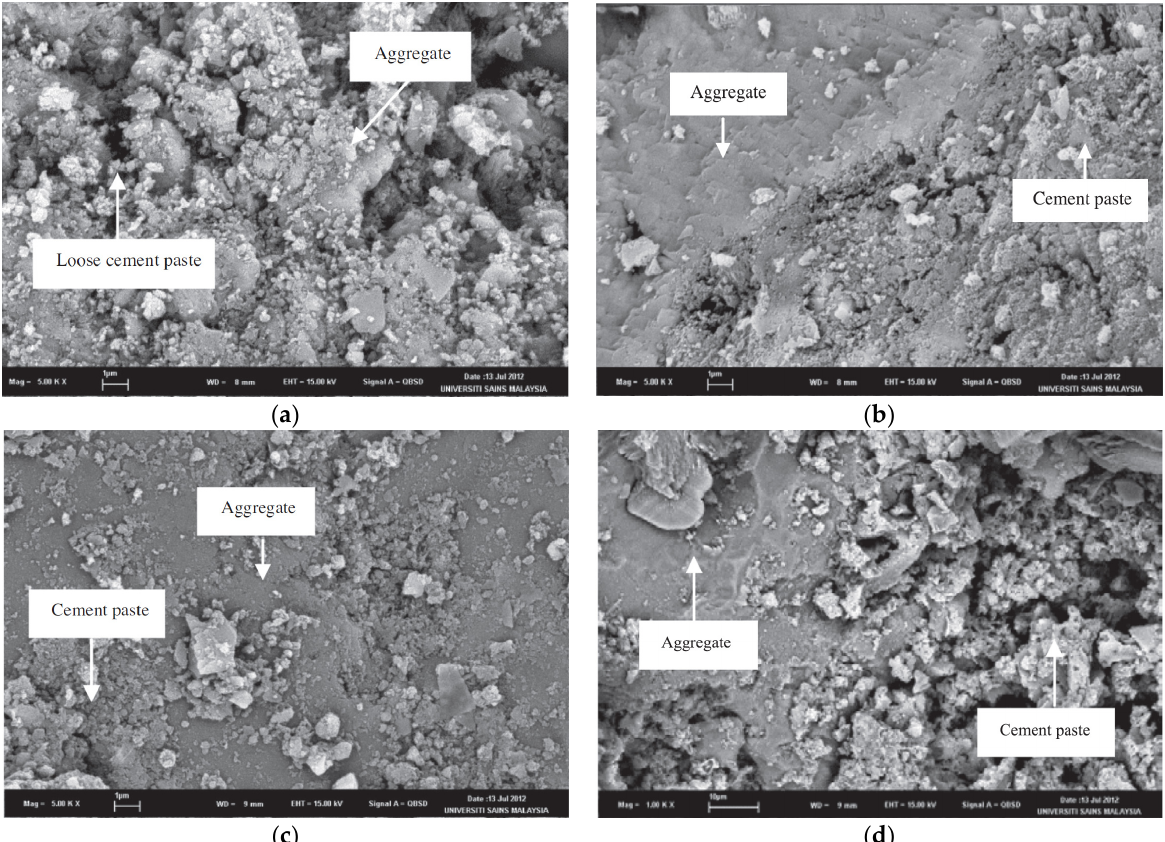
Figure 2. ( a ) Normal (untreated RCA); ( b ) treated RCA at 0.1 M; ( c ) treated RCA at 0.5 M; and ( d ) treated RCA at 0.8 M (Ismail and Ramli [9]).